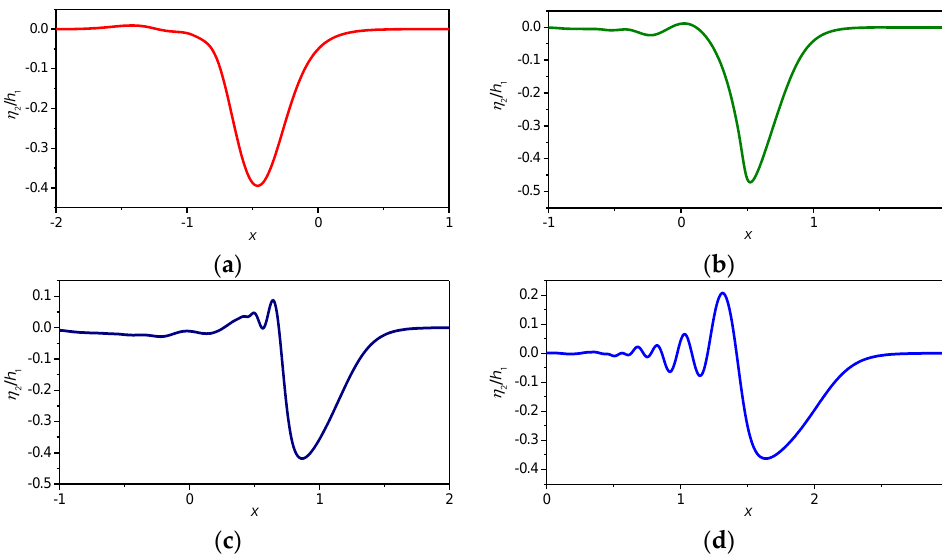
Figure 13. The change in the internal solitary wave profile as it propagates along the slope topography for the case a 0 /h 1 = 0.4 at moments t = 2 s ( a ), t = 4 s ( b ), t = 5s ( c ), t = 7s ( d ).The start point of the slope is located at x = 0, and the shoulder of the slope is at x = 0.5 with height h s =